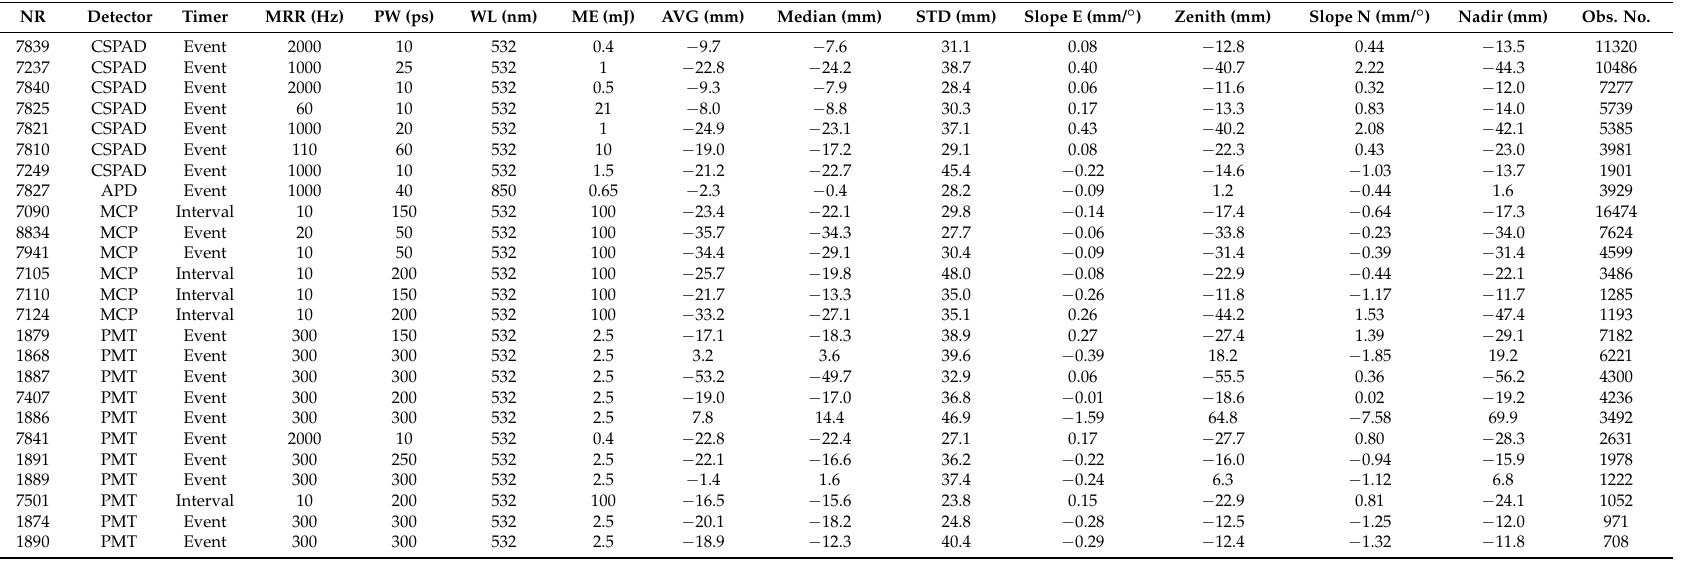
Table A1. Statistics for SLR stations, including characteristics of SLR residual as a function of the nadir angle and the elevation angle, data covers the period August 2015–July 2017, including SLR residuals to GLONASS-M satellites with uncoated LRA. Abbreviations used: NR, identification number of laser station;